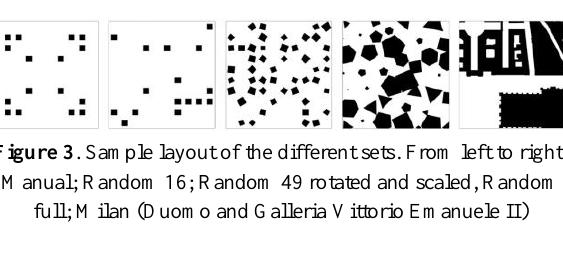
Figure 4 . Incremental buffer applied to a urban portion of Milan. At 140m (limit distance) all input buildings (210) are gathered in a single cluster (Biraghi, 2019). Plotting these values on a graph, with the number of iterations on the x axis and the number of clusters on the y axis, highlighted the peculiar nature of this discrete function (monotonically decreasing) and the fact that its trend was significantly different between urban contexts (Figure 5).